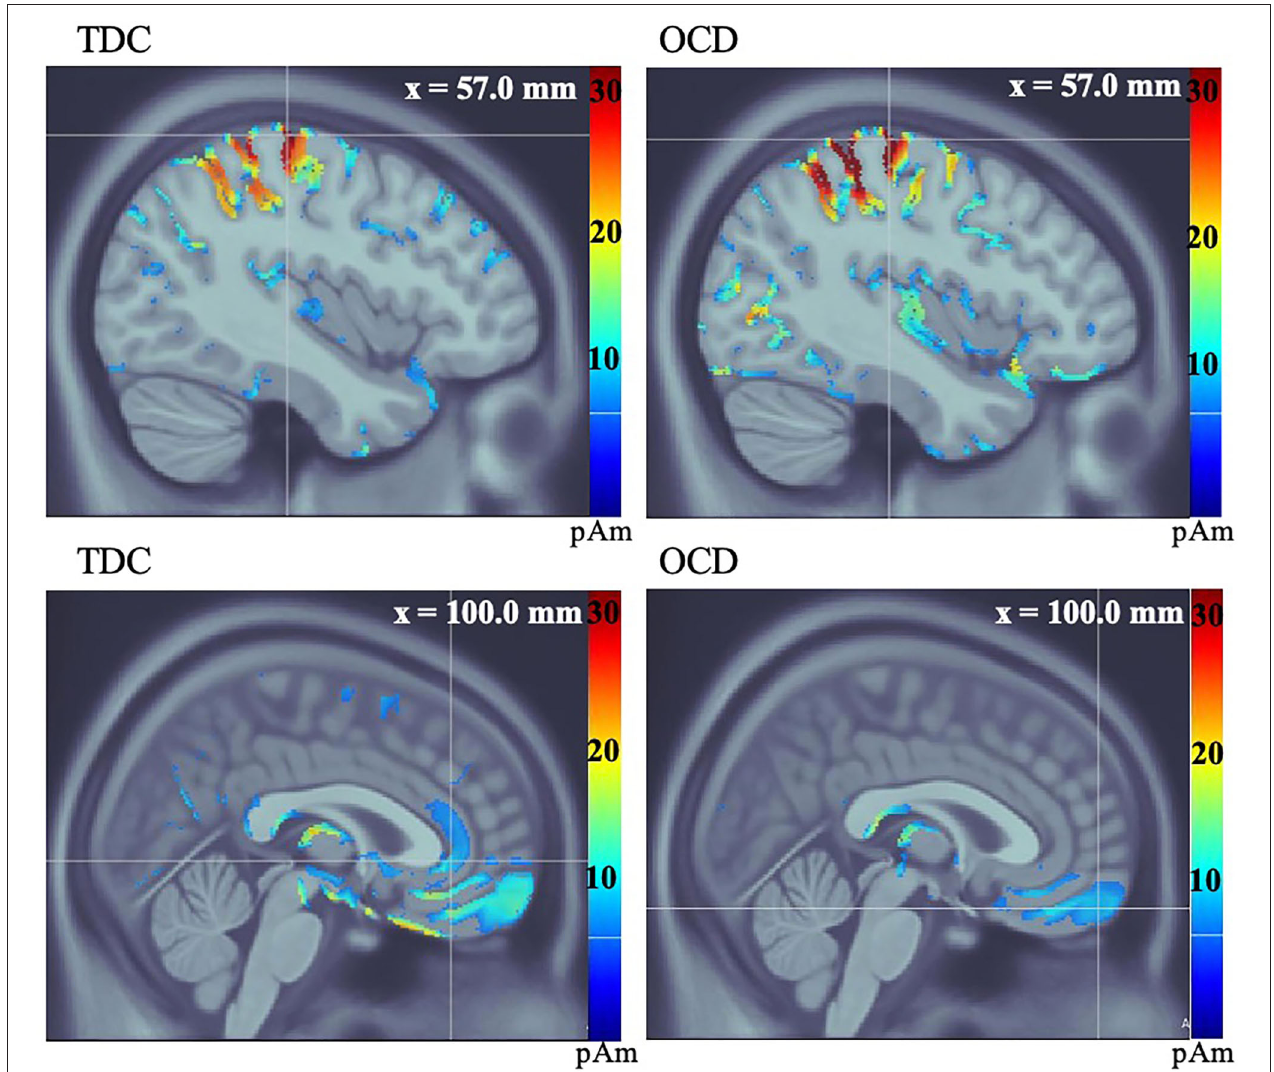
FIGURE 2 | Average group source localization during incorrect button-press in response to stop visual cue in No-Go condition, measured in picoamperes (pAm). TDC group motor (MI) response (top left), and orbitofrontal, and anterior cingulate cortices (bottom left). OCD group motor (MI) response (top right), and orbitofrontal cortex (bottom right). The OCD group does not show activation of the ACC at the group level (bottom